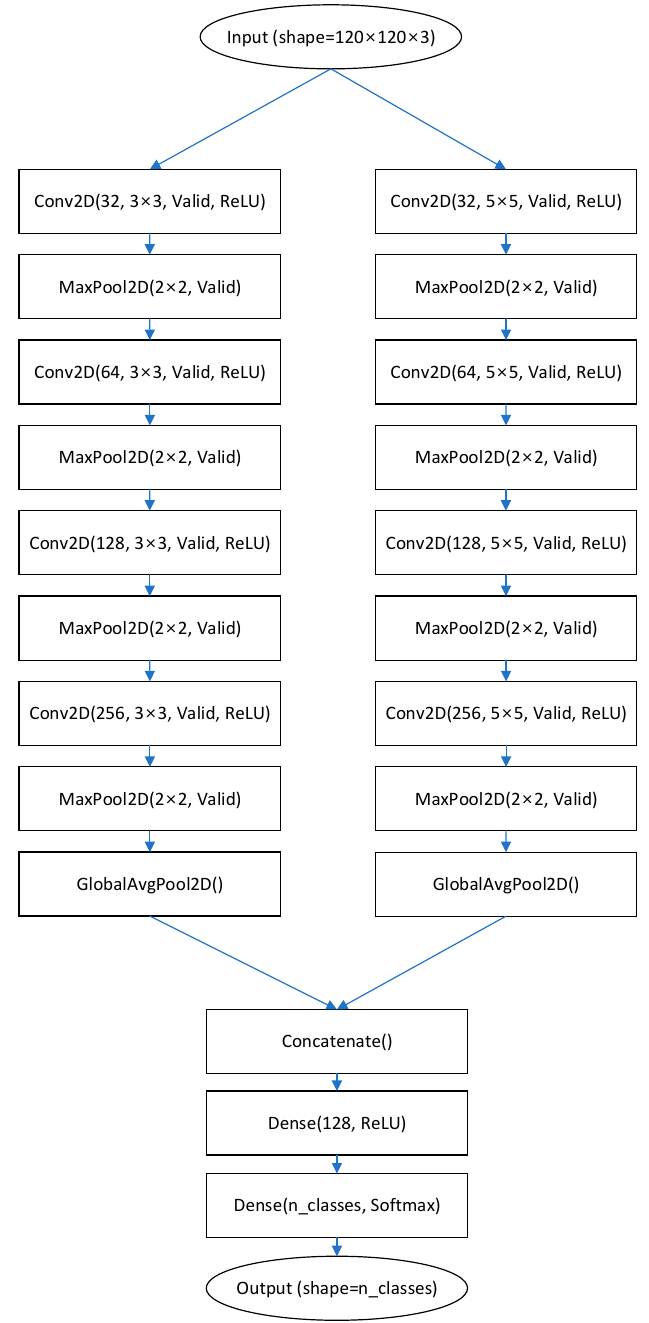
Figure 4. Structure of 4-layer dual CNN classifier.